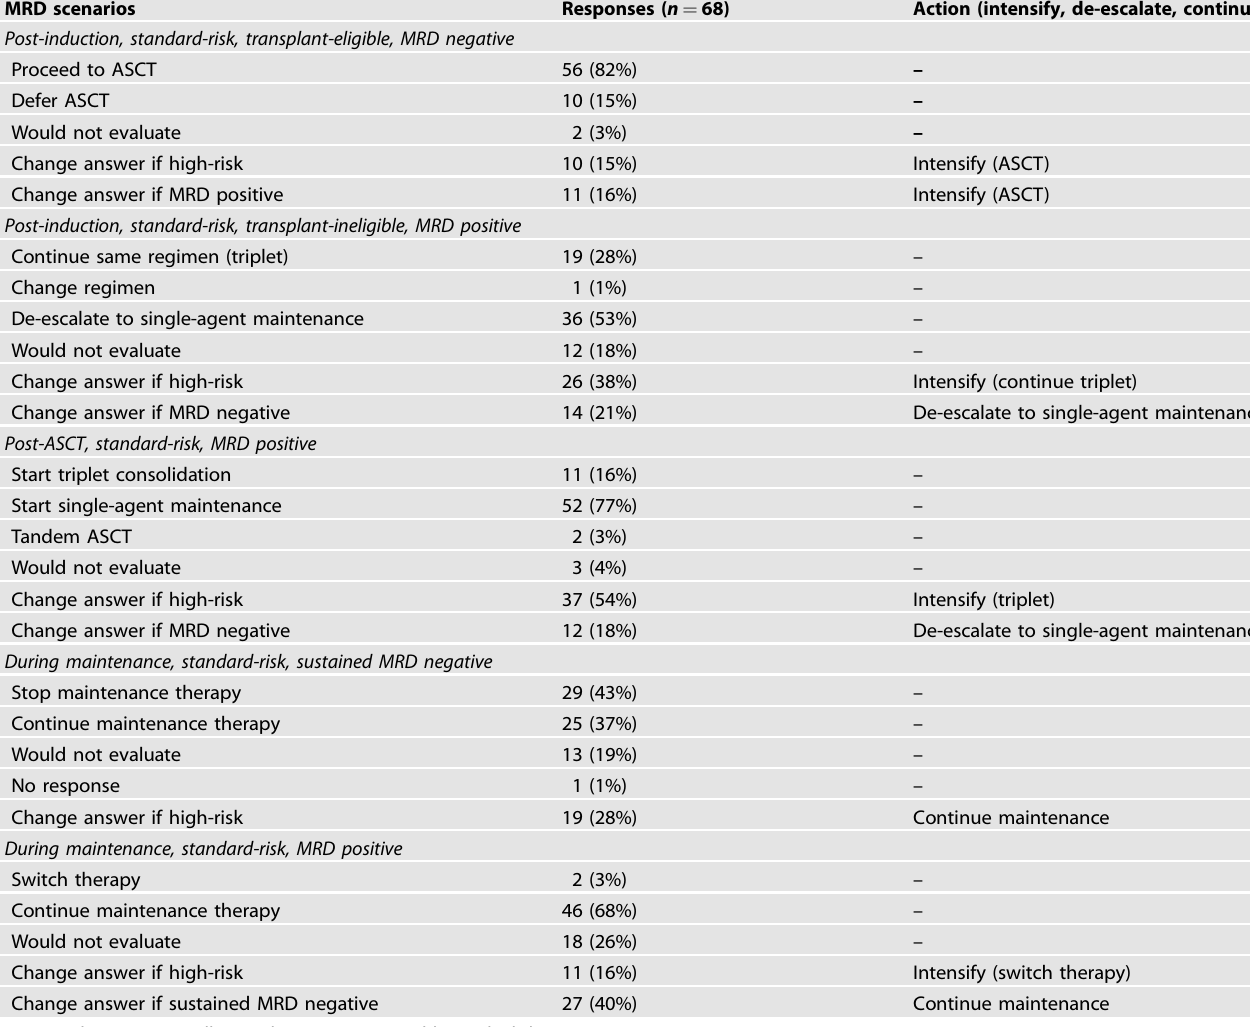
Table 3. Granular responses to different clinical scenarios in fi rst-line therapy for multiple